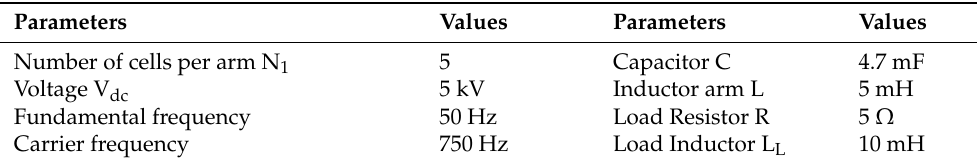
Table 1. Parameters of MMC circuit.